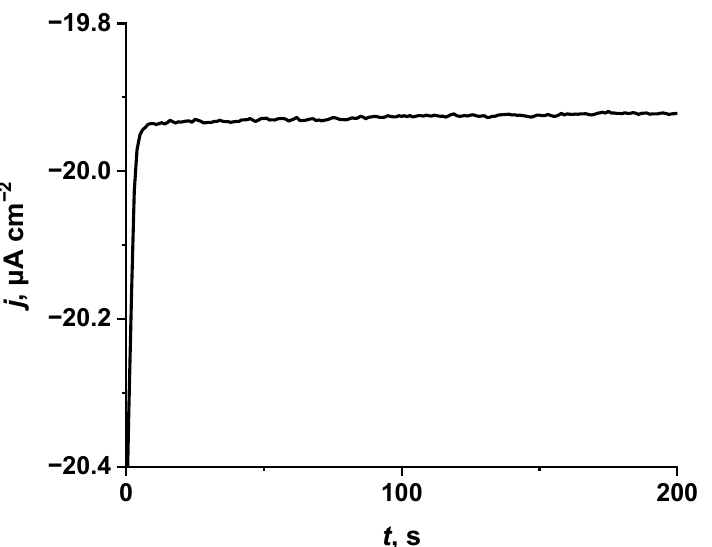
Figure 6. Chronoamperometric investigation of the glass|FTO|PB sensor in tap water (pH 5.5) with 13 µ mol L − 1 of FCL and 0.1 mol L − 1 of KCl. During chronoamperometric investigation 0 V vs. Ag|AgCl, KCl sat. potential was applied to the glass|FTO|PB sensor.